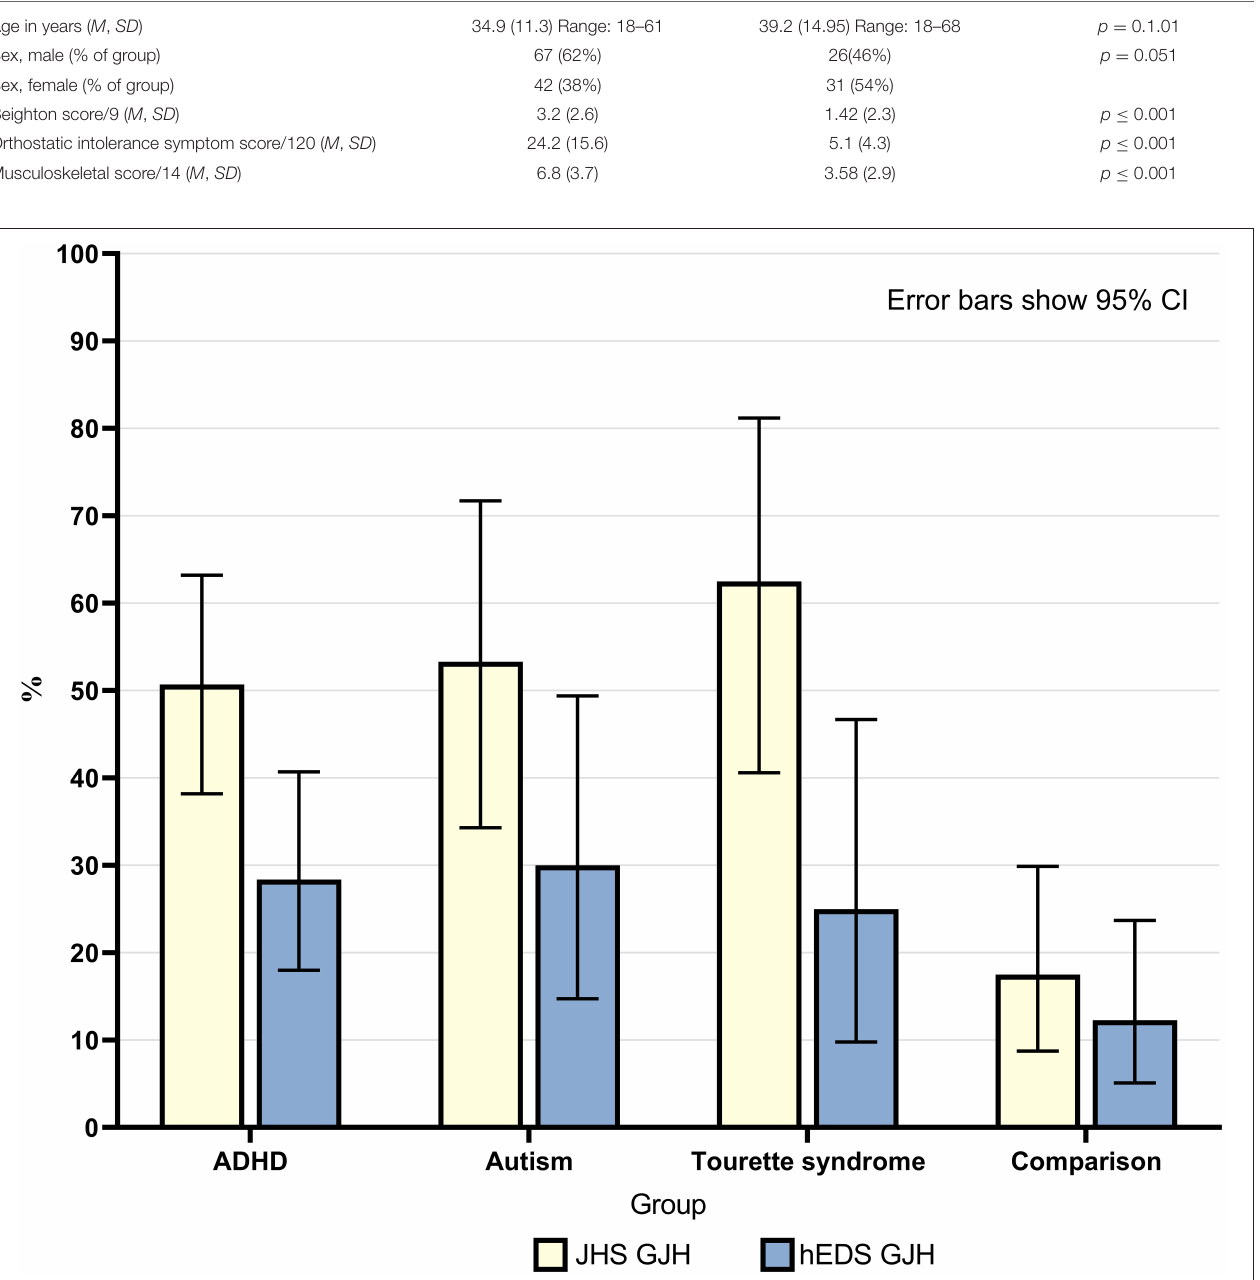
FIGURE 1 | Percentage of individuals in each group who had generalized joint hypermobility according to both JHS criteria (Beighton score ≥ 4) and 2017 hEDS criteria (age specific cut-off). Error bars show 95% CI.